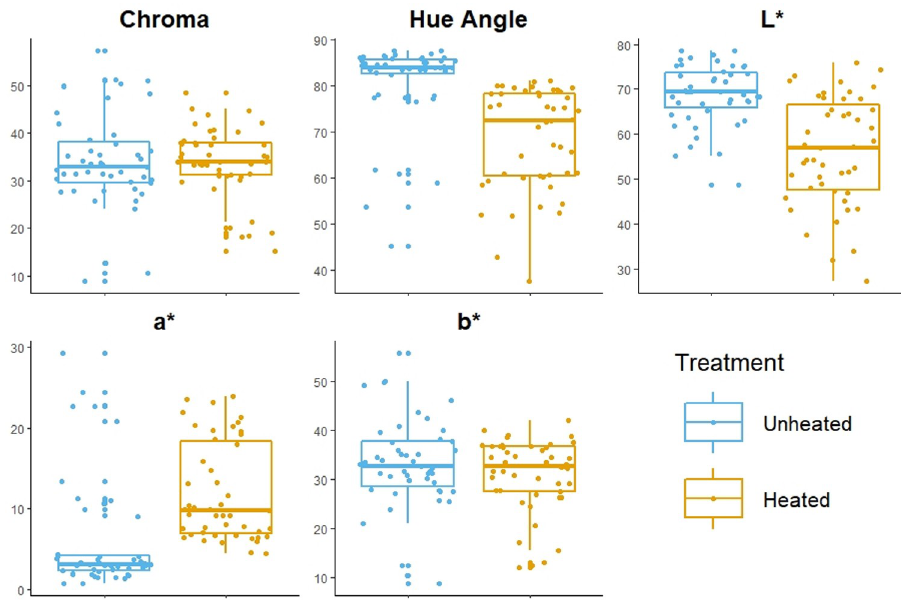
Fig 2. CIE L � a � b � variables across level of treatment. Boxplots comparing the distributions of five colorimetry variables (chroma, hue-angle, L � , a � , b � ) between unheated and heat-treated silcrete specimens from all three sources in this study.